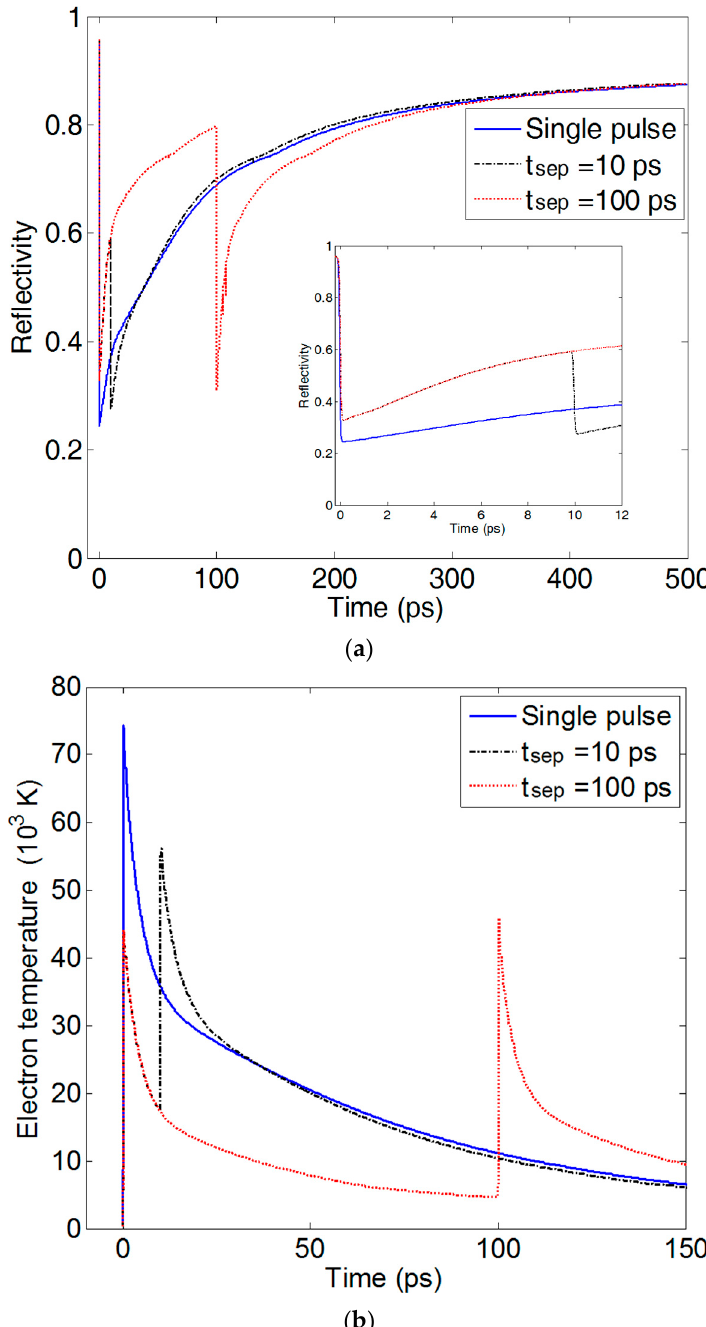
Figure 2. Cont. Figure 2.